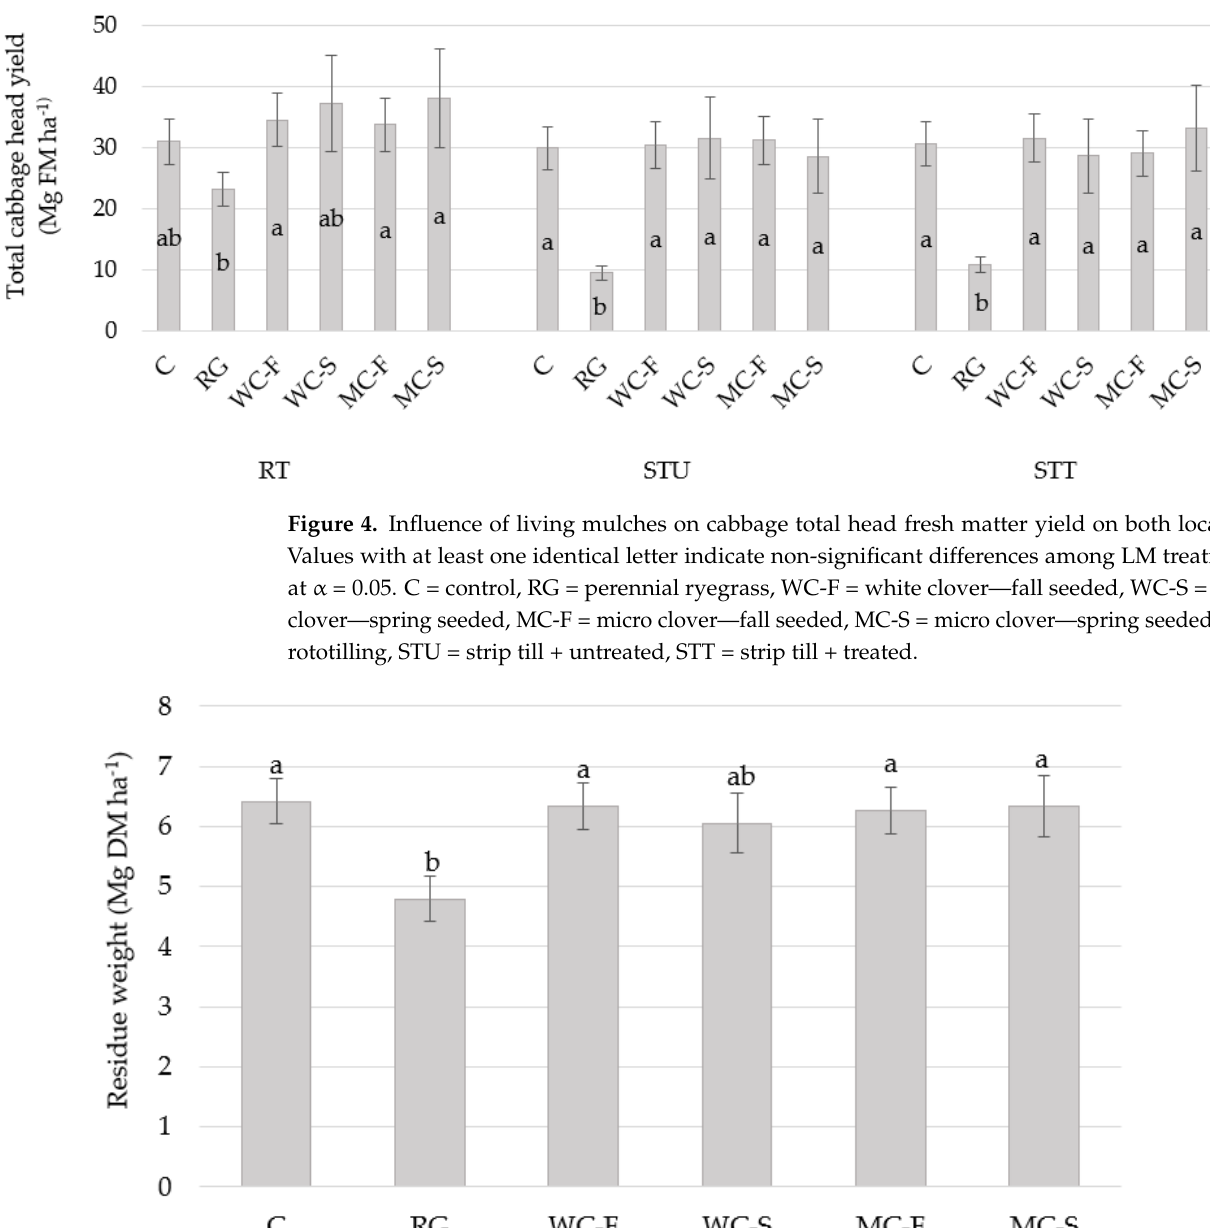
Figure 5. Influence of living mulch treatments on DM biomass of cabbage residues on both locations. Values with at least one identical letter indicate non-significant differences among LM treatments at α = 0.05. RT = rototilling, STU = strip till + untreated, STT = strip till + treated. At the time of cabbage harvest (D5) and four weeks after the harvest (D6), the differ- ence among the treatments of both factors, growth management and LM species as well as their interaction, were not